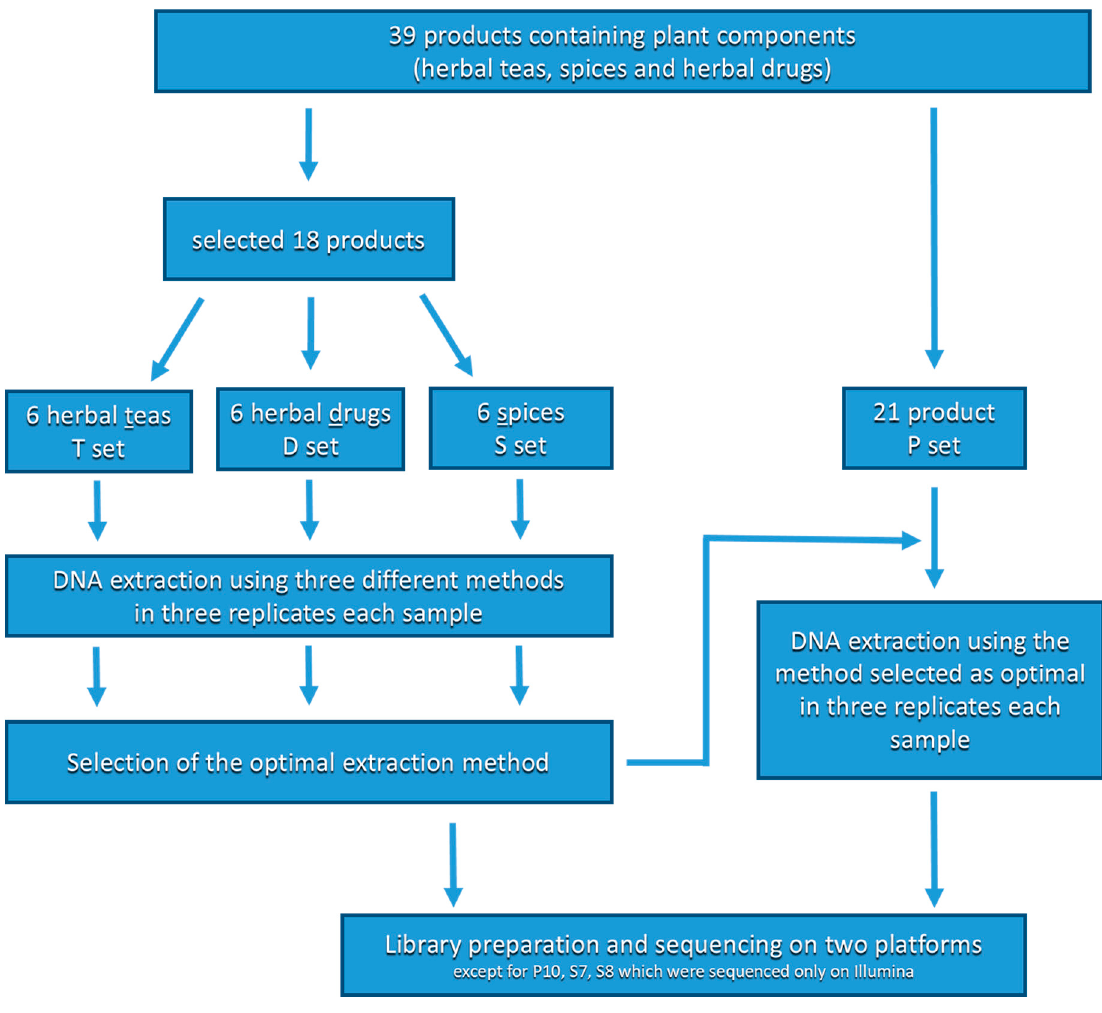
Figure 1. Scheme detailing the naming of samples and experiment design.